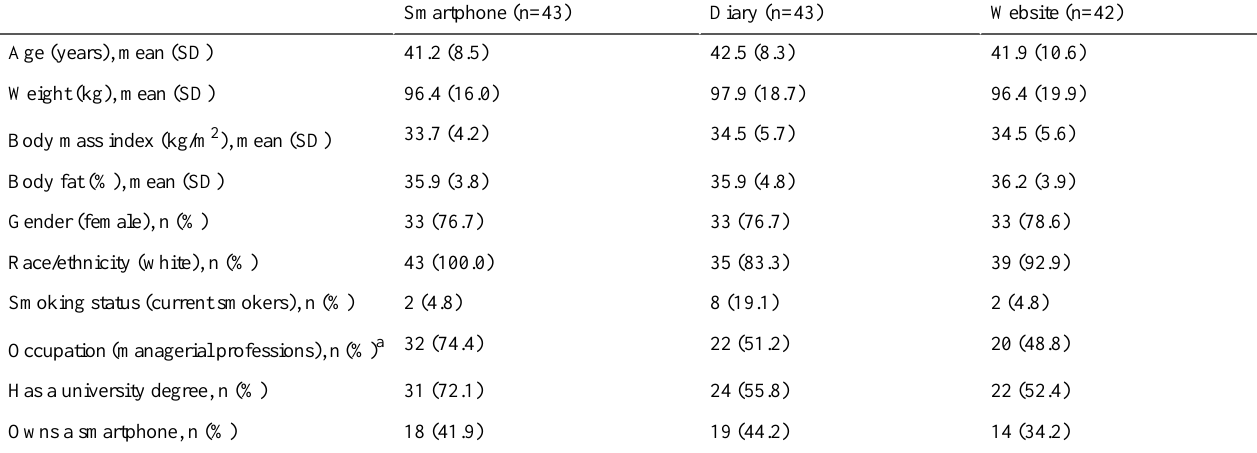
Table 1. Baseline characteristics of the participants enrolled in the 3 arms (smartphone application, website, or diary) of the 6-month pilot randomized controlled trial